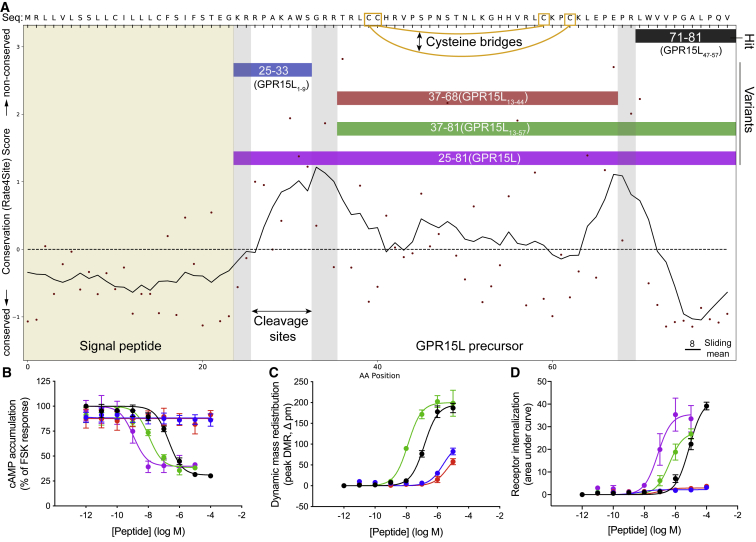
Potential Peptide Cleavage Variants Elicit Increased GPR15 Signaling Responses(A) Evolutionary trace and cleavage site (gray bars) analysis of the GPR15L gene-encoded precursor presents potential alternative peptide cleavage variants.(B–D) GPR15-mediated responses for GPR15L cleavage variants in (B) cAMP inhibition, (C) mass redistribution, and (D) receptor internalization assays. The most potent peptide is the longest, 57-residue form the recently named “GPR15L” (Suply et al., 2017) (excluded in C because of assay interference).Data represent mean ± SEM for 3–4 independent experiments performed in triplicate. Related pharmacological data for GPR15 as well as for cleavage variants of peptides activating BB3, GPR55, and GPR1 are shown in Table S7 and Figures S4 and S5.